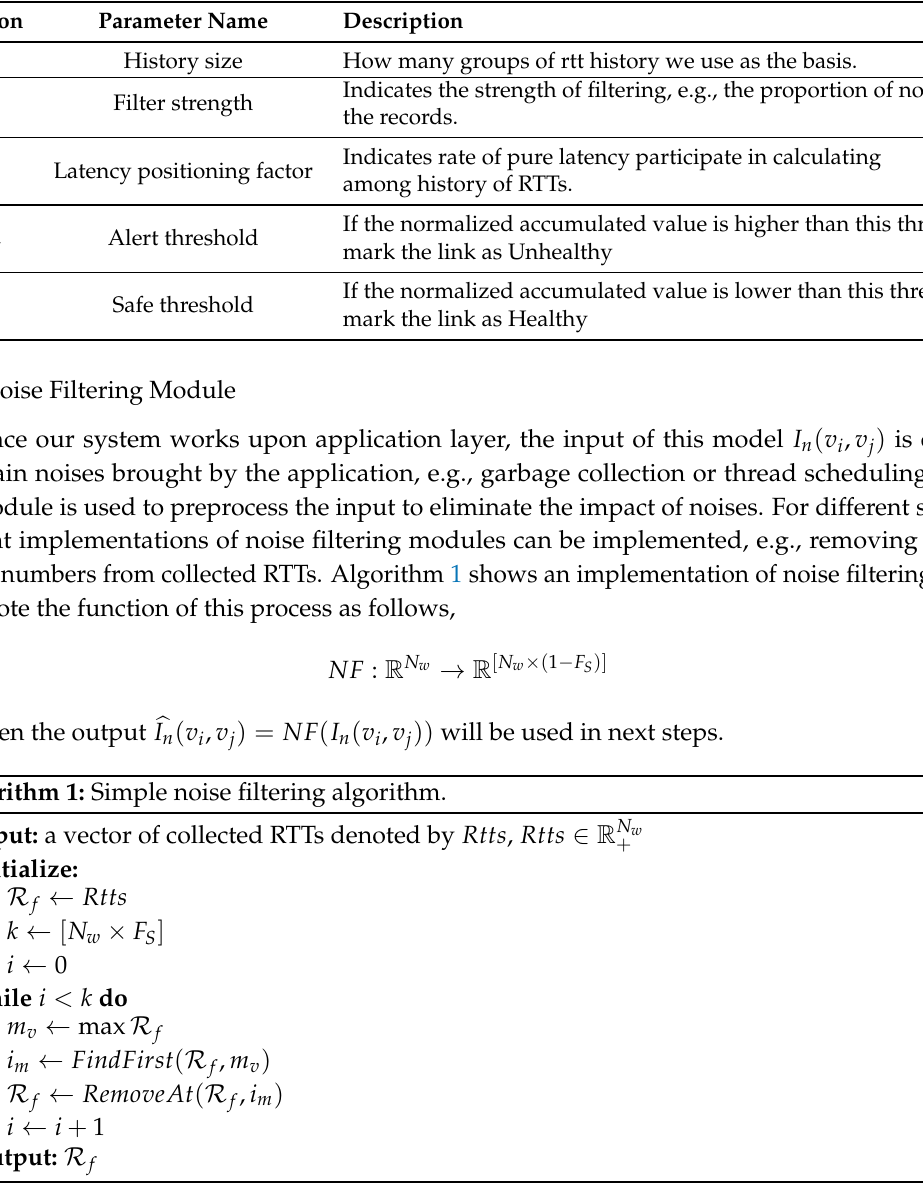
Table 3. Parameters of Link Evaluation Model.